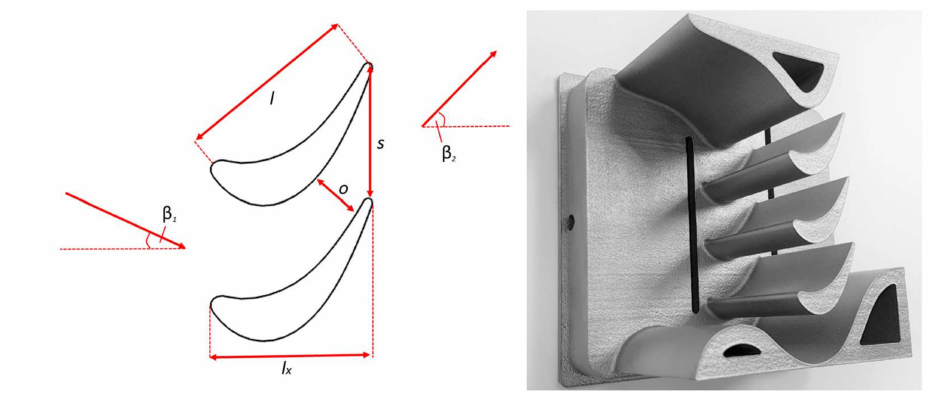
Figure 1. Geometric dimensions of the blade profiles and printed final design